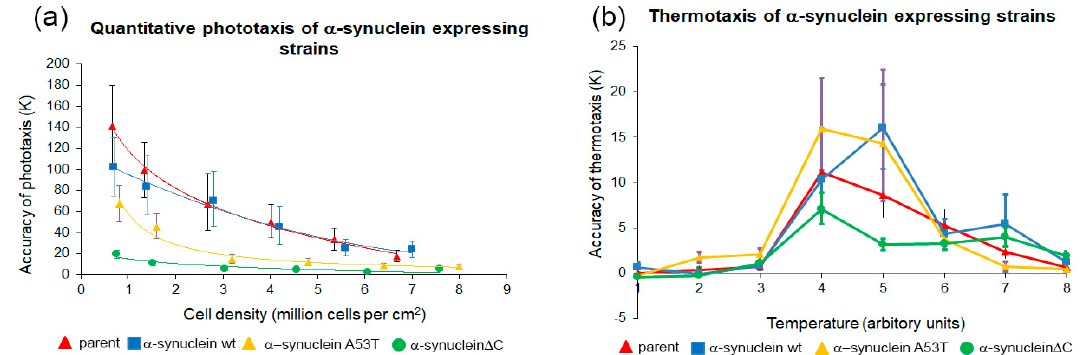
Figure 3. Mutant α -synuclein negatively affects phototaxis and thermotaxis. ( a ) Phototaxis. The parental strain (AX2), α -synuclein WT strain (HPF885), α -synuclein A53T mutant (HPF902) and α -synuclein Δ C mutant (HPF905) were statistically analysed and the accuracy of phototaxis ( κ ) was plotted against their cell densities. When compared to AX2, the two mutant forms showed significantly decreased accuracy of phototaxis with the α -synuclein Δ C mutant showing the lowest accuracy of phototaxis among the two forms. The α -synuclein WT strains showed a similar accuracy of phototaxis to AX2 at all cell densities. Error bars represent 90% confidence intervals. Lines were fitted with the least squares method to a logarithmic equation. ( b ) The accuracy of thermotaxis ( κ ) by slugs of the parental strain (AX2), and strains expressing the α -synuclein WT (HPF885), A53T point mutant (HPF902) and α -synuclein Δ C mutant (HPF905) proteins was plotted against the temperature. The temperatures are expressed in arbitrary units from 1 to 8, shown in separate calibration experiments to correspond to agar surface temperatures of 14 °C to 28 °C at the centre of the plate [44] . When compared to AX2, strains expressing the α -synuclein Δ C mutants show significantly reduced accuracy of thermotaxis while those expressing the α -synuclein WT or the α -synuclein A53T mutant form show a similar thermotaxis phenotype to AX2. Error bars represent 90% confidence intervals.